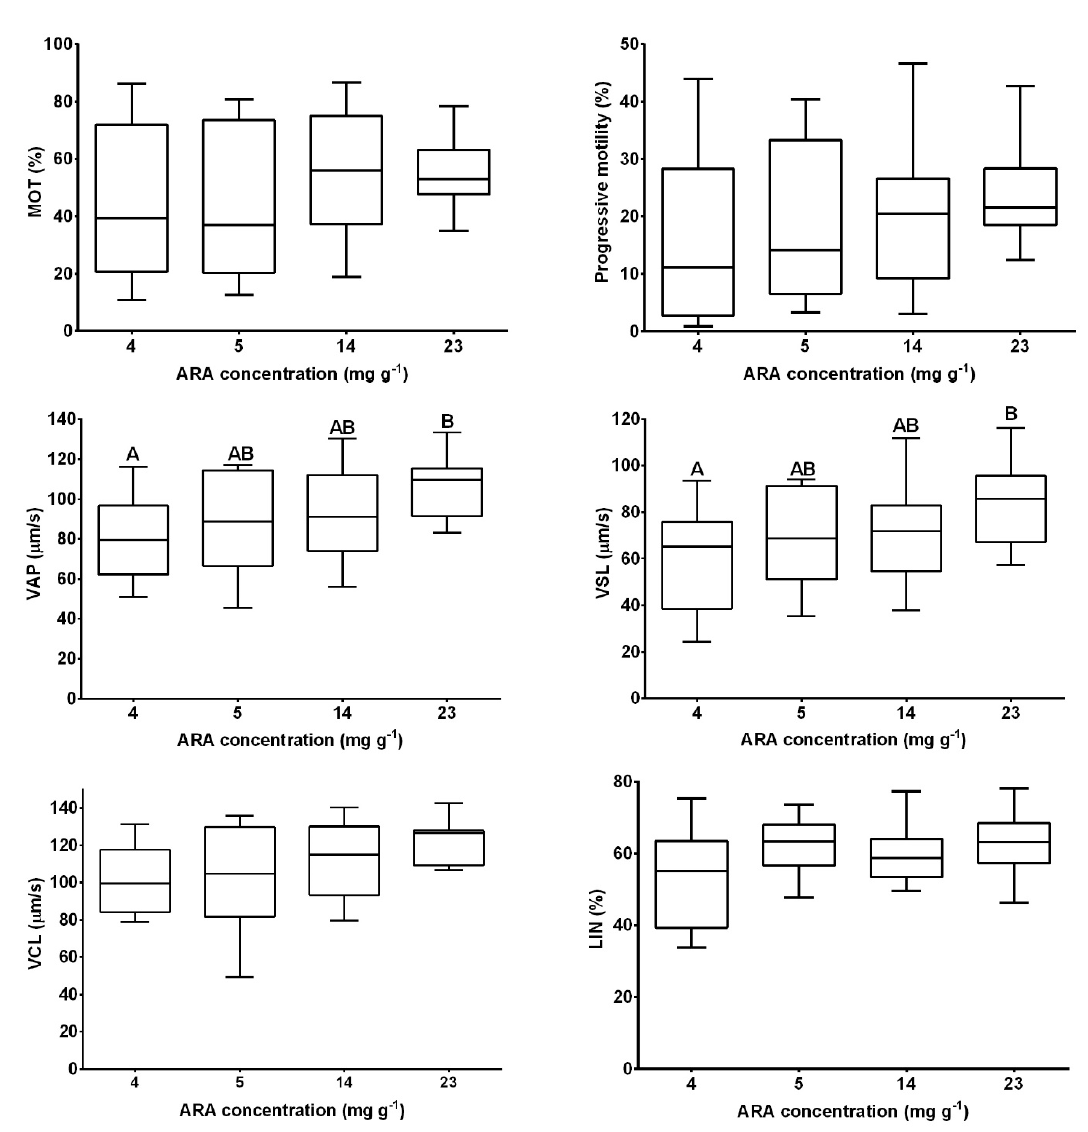
Figure 2. Medaka sperm motility parameters after three weeks of experimental diet feeding with di ff erent amounts of ARA as follows: 4, 5, 14, 23 mg ARA g − 1 of total fatty acid (TFA). Data are expressed as means ± standard deviation (SD) ( n = 15). Following sperm motility parameters are given: The percentage of motile sperm (MOT, %), progressive motility (%), average path velocity (VAP, µ m s − 1 ), straight line velocity (VSL, µ m s − 1 ), curvilinear velocity (VCL, µ m s − 1 ) and linearity (LIN = 100 × VSL / VCL, %). Di ff erent letters above the bars indicate significant di ff erences ( p < 0.05) between groups.